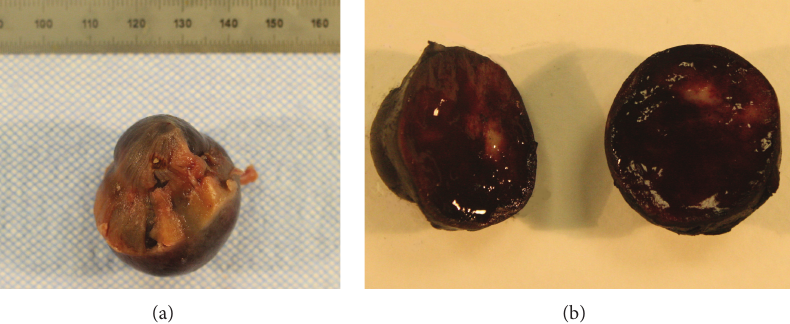
Figure 2: (a) At external inspection, tumor is blue-black and capsular surface is thickened. (b) In cross section, tumor is dark red and hemorrhagic with an irregular area of white-tan parenchyma, 2.4 cm in greatest